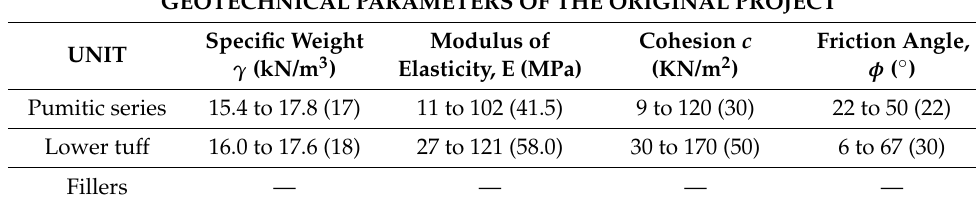
Table 1. Geotechnical parameters of the original project.